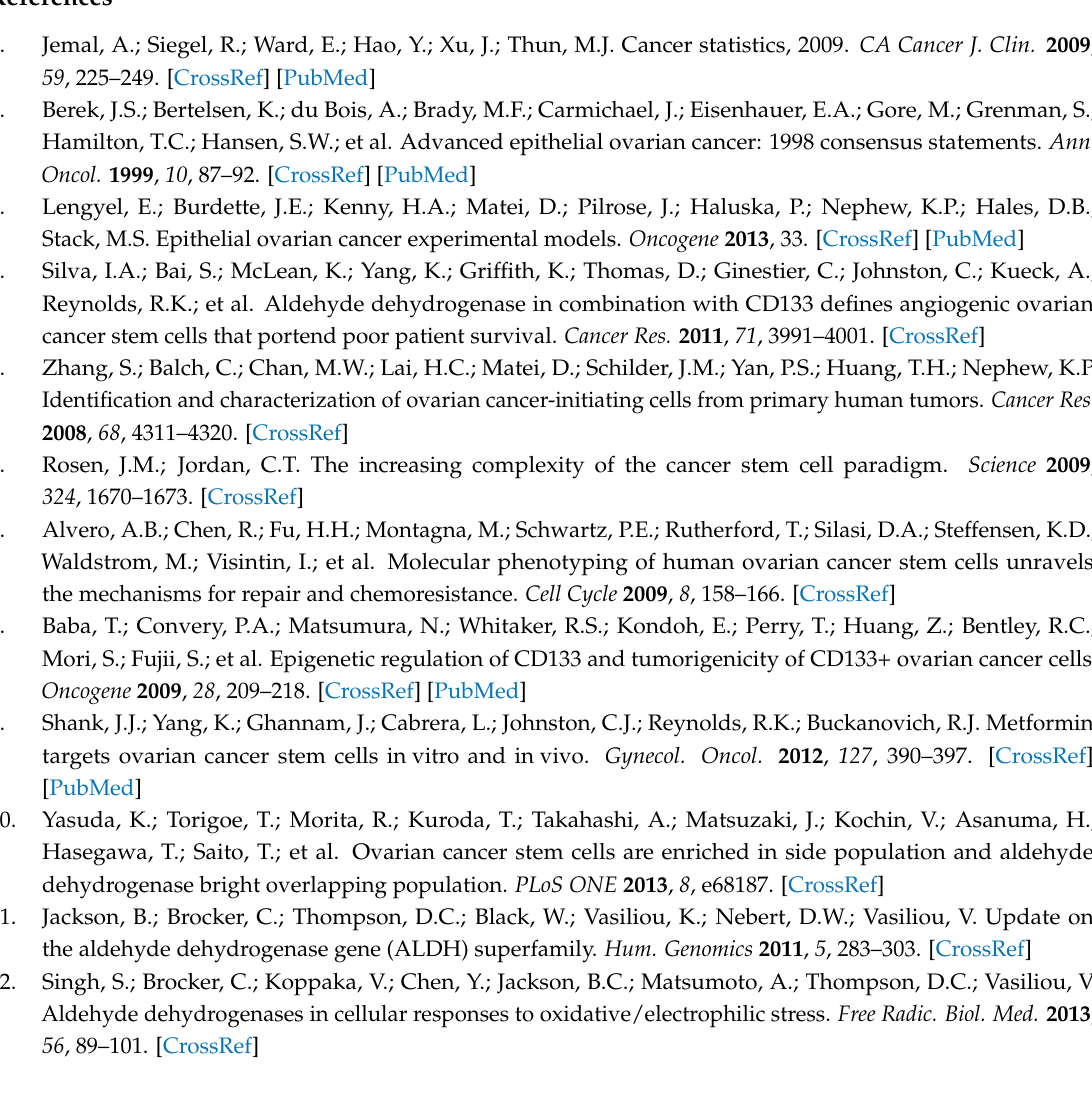
Figure S1: ALDH1A3 expression in cells transfected with sh-RNA targeting ALDH1A1 or scrambled